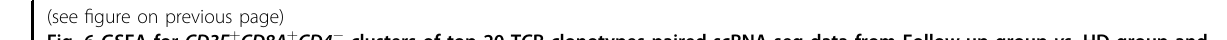
Fig. 6 GSEA for CD3E + CD8A + CD4 − clusters of top 20 TCR clonotypes paired scRNA-seq data from Follow-up group vs . HD group and pseudo-time analysis of paired samples from Discharged and Late Follow-up groups. a Using GSEA to analyze expressed genes from CD3E + CD8A + CD4 − clusters of top 20 TCR paired scRNA-seq data, 2 metabolism-related gene sets signi fi cantly upregulated in Follow-up group comparing with HD group ( n = 7 in Follow-up group, n = 6 in HD group), and b a fatty acid metabolic gene set signi fi cantly upregulated in Late Follow-up group vs . HD group analysis ( n = 4 in Late Follow-up group, n = 6 in HD group). NES, normalized ES; FDR, false discovery rate; NOM p, normalized p value. c Distribution of each group in CD8A + GZMK + T effector memory subset. d Pseudo-time analysis of top 20 T cell clones from Discharged and Late Follow-up paired samples. Upper panel, CD8A + GZMK + Tem subset of combined Discharged and Late Follow-up samples. The arrows indicate the cells ’ differentiation trajectories from the beginning to the end; Lower panel, separated Discharged and Late Follow-up groups in CD8A + GZMK + Tem subset ( n = 3 per group). e Pseudo-time analysis of top 20 T cell clones from Discharged and Late Follow-up paired samples. Left panel, distribution of CD8A + CXCR5 + Tcm subset; right panel, only the Late Follow-up samples contributed in CD8A + CXCR5 + Tcm subset ( n = 3 per group). DC, Discharged group; FU, Follow-up group; HD, Healthy Donor group; Tcm, central memory T cells; Tem, effector memory T cells.